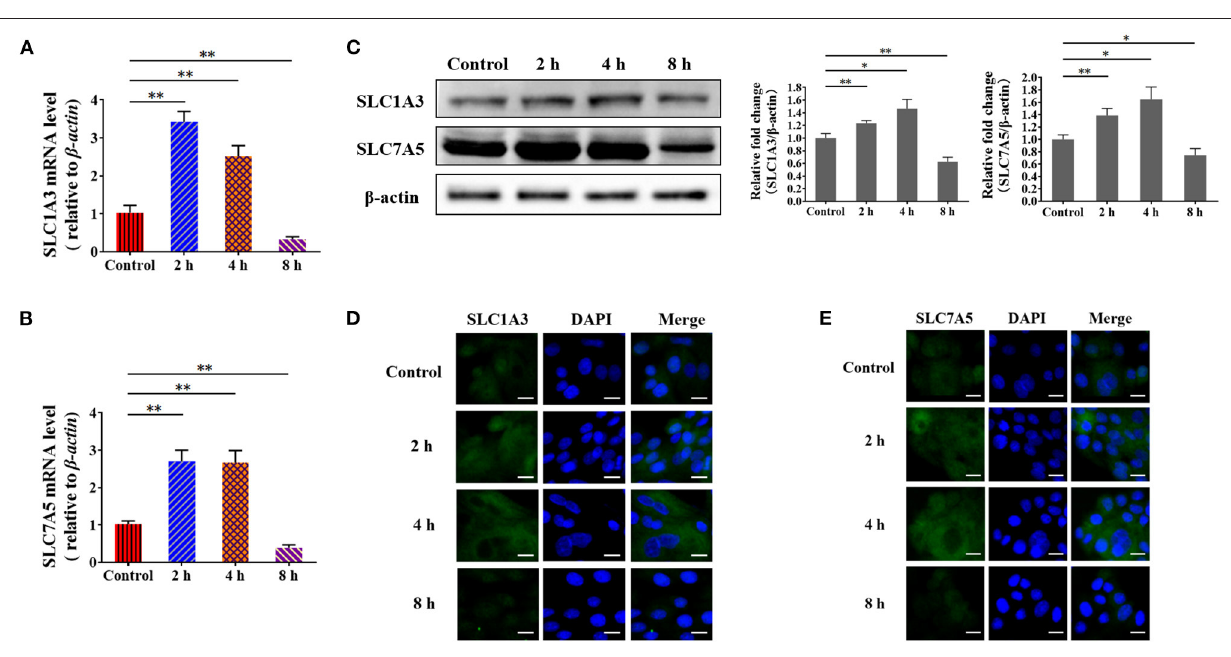
FIGURE 5 | Staphylococcus aureus infection impairs the expression of amino acid transporter genes at 8h. (A,B) mRNA levels of SLC1A3 (A) and SLC7A5 (B) in S. aureus -infected BMECs. (C) Protein levels of SLC1A3 and SLC7A5 in S. aureus -infected BMECs. (D,E) Immunofluorescence assay of SLC1A3 (D) and SLC7A5 (E) in infected BMECs and control. Representative confocal microscopy images of SLC1A3 and SLC7A5 (Green) in cells that were co-stained with DAPI (blue). Scale bars represent 20 µ m. The resolved bands were quantified using Gel-Pro Analyzer 4.0 (Media Cybernetics, Inc., Rockville, MD, USA). * p < 0.05; ** p < 0.01. n = 3 independent